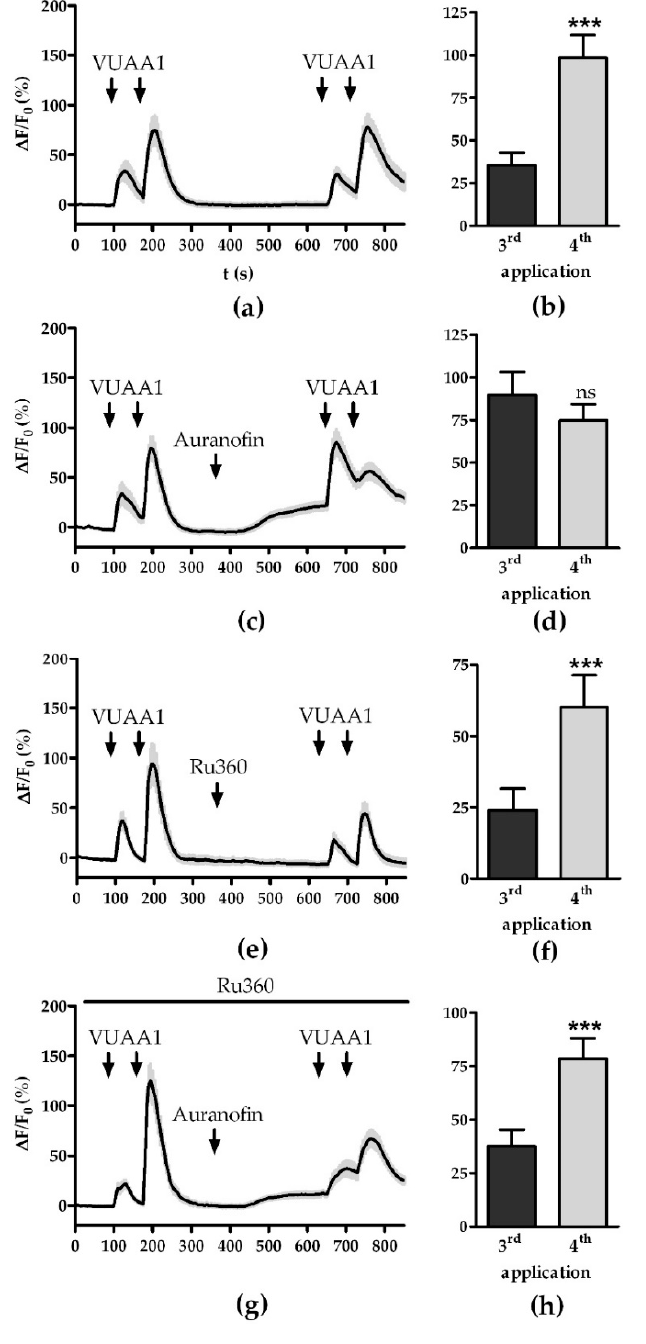
Figure 3. Effect of modulators of mitochondrial Ca 2+ export and import on fluorescence time courses: ( a , b ) OR responses ( a ) and maximum fluorescence ( b ) upon stimulation with VUAA1 under control conditions ( n = 31); ( c , d ) OR responses ( c ) and maximum fluorescence ( d ) upon stimulation with VUAA1 in absence and presence of mPTP activator auranofin ( n = 31); ( e , f ) OR responses ( e ) and maximum fluorescence ( f ) upon stimulation with VUAA1 in absence and presence of mCU inhibitor Ru360 ( n = 27); ( g , h ) OR responses ( g ) and maximum fluorescence ( h ) upon stimulation with VUAA1 in presence of mCU inhibitor Ru360 and mPTP activator auranofin ( n = 26). Data represent mean ± SEM, Student’s paired t -test, ns p > 0.05, *** p < 0.001. Using the sensitization index as described in [30] to assess our data, we found that there were no quantitative differences between the effects evoked by Ca 2+ release through CCCP or auranofin. Furthermore, the application of Ru360 did not affect the sensitization index and was able to rescue effects evoked by auranofin (Figure 4).